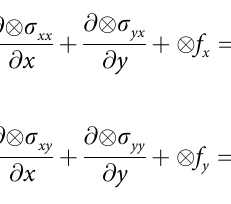
4.2.2 The geometric equations with grey variables. The geometric equations with grey variables are